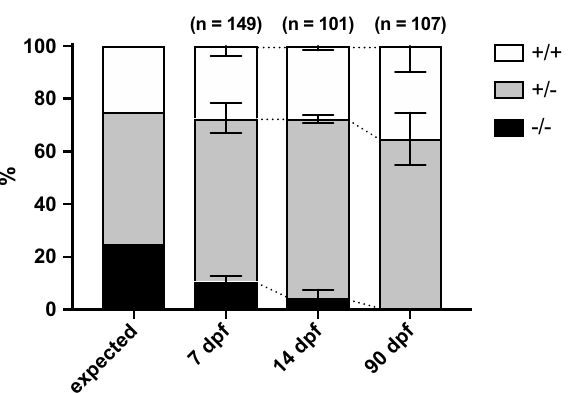
Figure 4. lpgat1 homozygous mutants were not reproduced with the expected Mendelian ratio. Genotypes of offspring from crossing between heterozygotes ( lpgat1 +/− ). The genotypes of littermate zebrafish obtained by crossing lpgat1 +/− males and females were determined at each time point. Data at 7, 14, and 90 dpf were obtained from 4, 3, and 7 independent crosses, respectively. The data of mutants 1 and 2 were combined. The numbers of larvae analyzed are indicated on the top of each bar. Error bars are